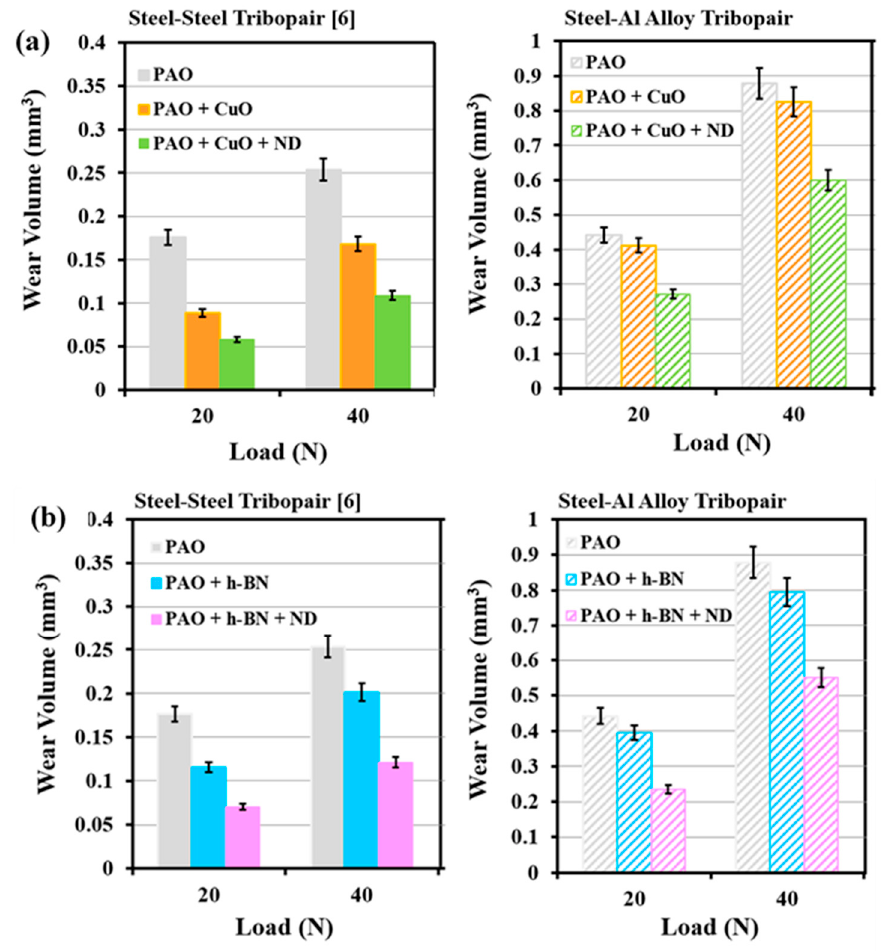
Figure 18. Volumetric wear of En31 steel discs [10] and Al alloy discs when AISI 52100 steel balls were slid against the discs under: under: ( a ) PAO, PAO + CuO primary additive/+ ND secondary additive lubricants and ( b ) PAO, PAO + h-BN pri-mary additive/+ ND secondary additive lubricants.